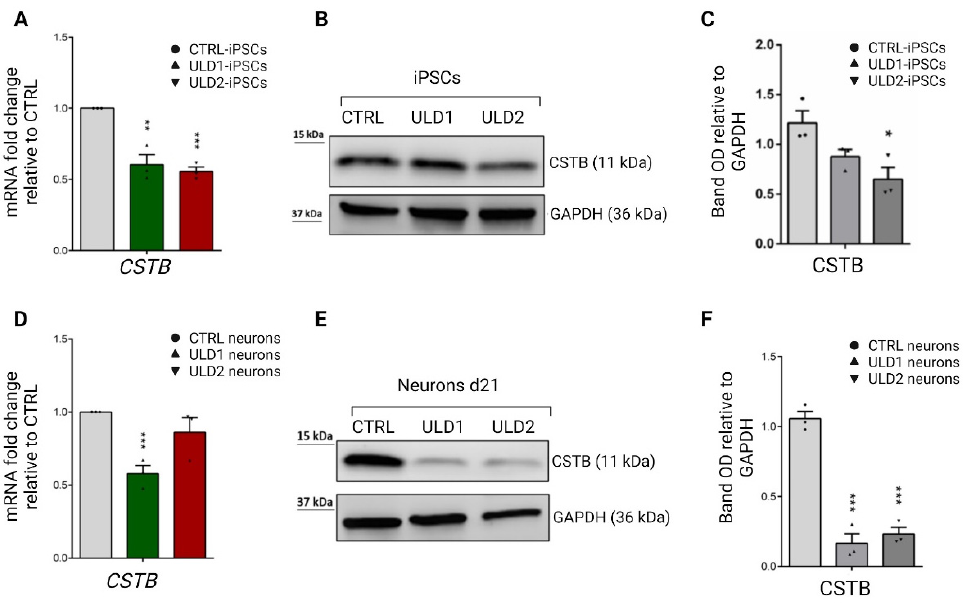
Figure 4. Expression of CSTB gene and protein in iPSCs and neurons derived from CTRL and ULD patients. (Top panel) ( A ) qRT-PCR analysis of CSTB gene in iPSCs. ULD patient-specific iPSCs show a significantly lower expression of CSTB compared to CTRL iPSCs. ( B ) Western blot analysis of CSTB protein in total lysates obtained from CTRL, ULD1, and ULD2 iPSCs. ( C ) Densitometric analysis of WB results, performed using ImageJ software. (Bottom panel) ( D ) qRT-PCR analysis of CSTB gene in neurons at day 21 of differentiation. ULD patient-derived neurons, particularly ULD1, show a lower expression of CSTB compared to CTRL neurons. ( E ) Western blot analysis of CSTB protein in total lysates obtained from CTRL, ULD1, and ULD2 neurons show a significant decrease of CSTB protein expression in patient’s cells compared to control. ( F ) Densitometric analysis of WB results, performed using ImageJ software. In all WB analyses GAPDH was used as loading control. Both qRT-PCR and WB data are presented as mean ± SEM of three independent experiments (black dots), * p ≤ 0.05, ** p ≤ 0.01, *** p ≤ 0.001. For neurons, t-test has been calculated vs. CTRL at the same day of